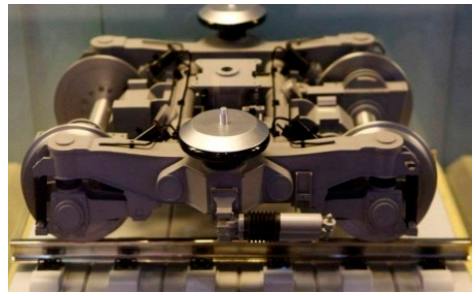
Figure 2. Physical map of bogie.